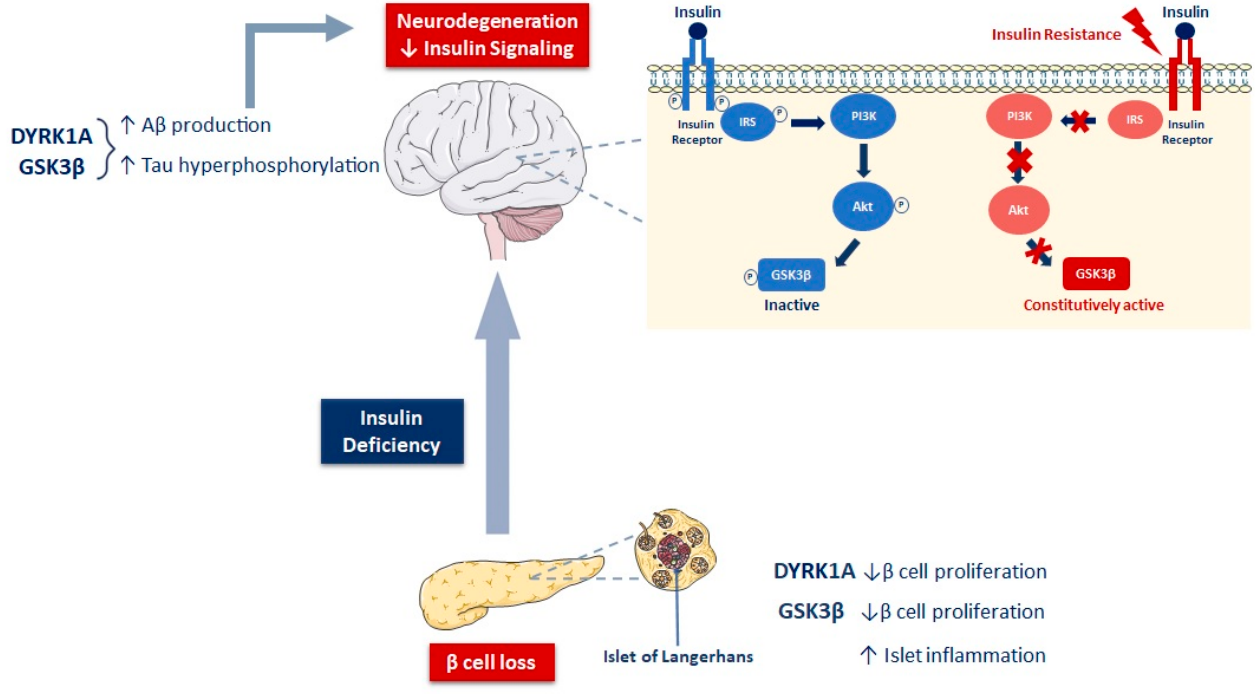
Figure 2. DYRK1A and GSK3 β enzymes: potential molecular actors implicated in pancreatic β -cell loss and neurodegeneration. Under physiological conditions, insulin inhibits GSK3 β activity by phosphorylating it via the PI3K/Akt pathway. In the case of insulin resistance, GSK3 β remains dephosphorylated and constitutively active, resulting in the hyperphosphorylation of tau. The aberrant activation of DYRK1A and GSK3 β in the brain increases A β peptide production and causes the hyperphosphorylation of tau, resulting in the formation of amyloid plaques and neurofibrillary tangles, respectively. These aggregates cause neurodegeneration and induce the alteration of brain insulin signaling. In the endocrine pancreas, both DYRK1A and GSK3 β inhibit β -cell proliferation, and GSK3 β is associated with the inflammation of the islets of Langerhans. This leads to β -cell loss and insulin secretion deficiency, further aggravating the impaired insulin signaling in the brain. In addition, GSK3 negatively regulates Wnt signaling, which is an important path- way involved in synaptic plasticity. Thus, in cerebral insulin resistance, the hyperactiva- tion of GSK3 participates in the impairment of synaptic plasticity [143]. A β peptides can also induce GSK3 dysregulation [158]. Indeed, since the insulin [180] and Wnt [220] sig- naling pathways are targeted by A β peptide toxicity, amyloid accumulation also contrib- utes to an increased activation of GSK3 β , and consequently leads to tau hyperphosphor- ylation, thus establishing a link between senile plaques and NFTs in AD [158,213]. Interestingly, elevated levels of hyperphosphorylated tau have been found in the is- lets of Langerhans of T2D patients, indicating that tau pathology is also a hallmark of T2D [190]. Tau is expressed in pancreatic β cells, where its phosphorylation/dephosphorylation plays a role in insulin trafficking and secretion [221]. Our team has significantly contrib- uted to the establishment of the role of GSK3 β as a negative regulator of β -cell growth and function. We provided the first evidence for the implication of the Wnt/ β -catenin signaling pathway in the regulation of the physiological expansion of the β -cell mass during the early post-natal period [222]. Moreover, GSK3 β downregulation by pharmacological or genetic modulators resulted in the stimulation of β -cell regeneration in neonatal diabetes induced by streptozotocin [222]. Likewise, in a more recent study, we reported that the local intrapancreatic knockdown of GSK3 β in 90%-pancreatectomized rats promoted β - cell and exocrine cell regeneration in the remnant pancreatic tissue by stimulating cell proliferation and neogenesis [223]. Other studies have shown that transgenic mice